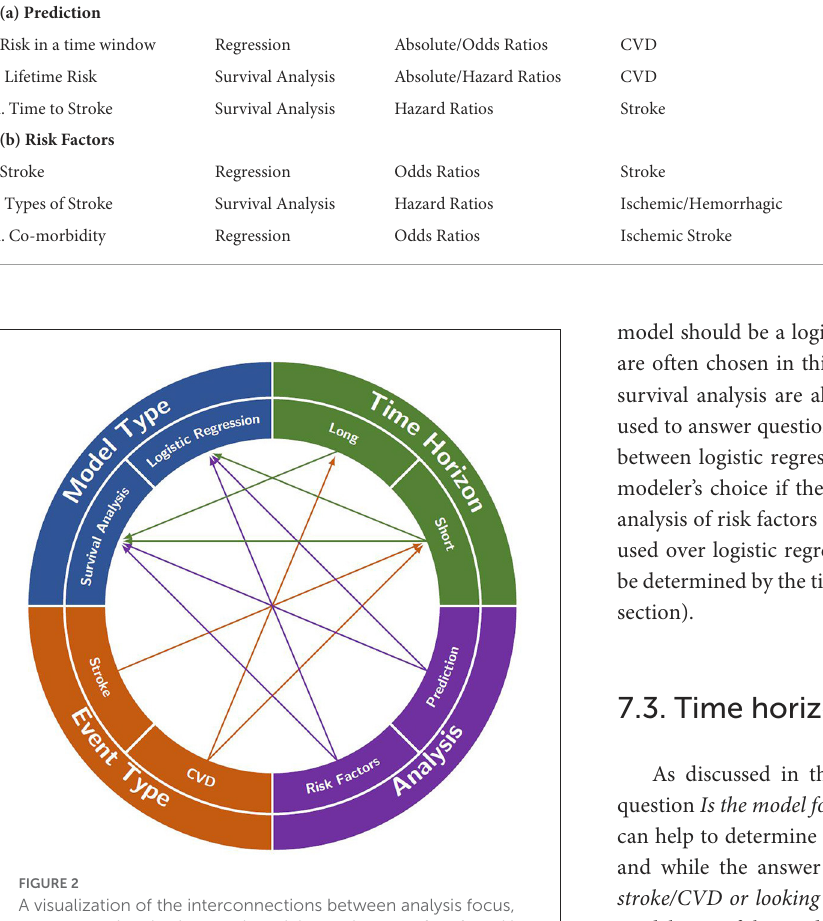
TABLE 1 Classification of risk models by a number of factors that define the model with examples of models that fit into each category. Analysis